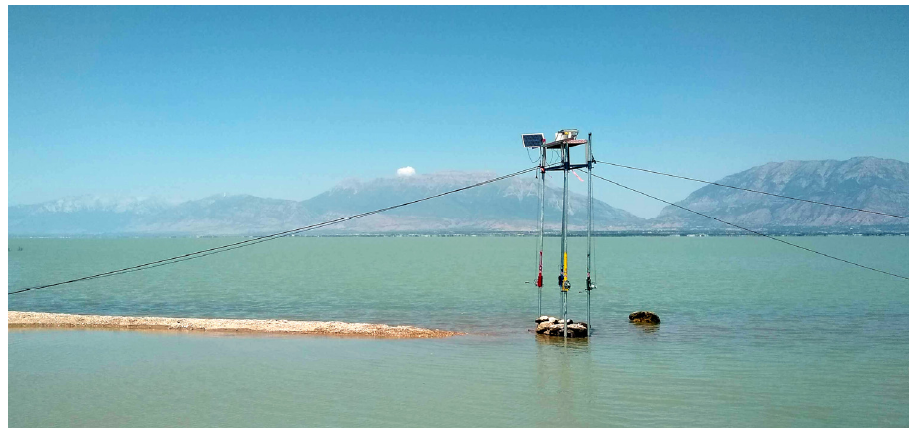
Figure 6. The mid-lake sample location on the east side of Bird Island.